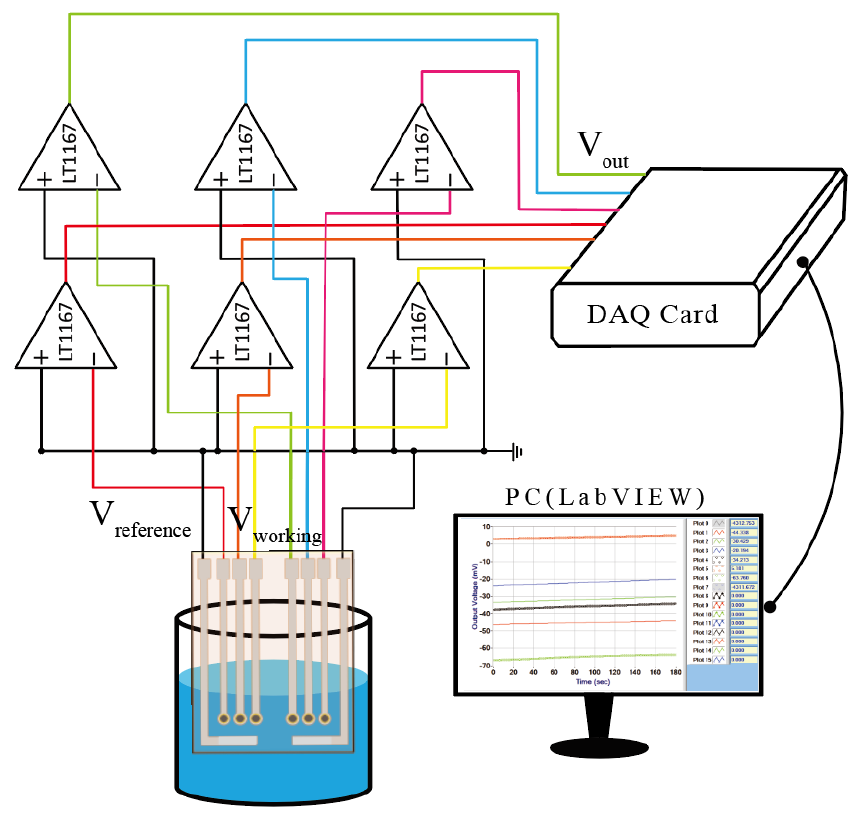
Figure 4. The V-T measurement system.